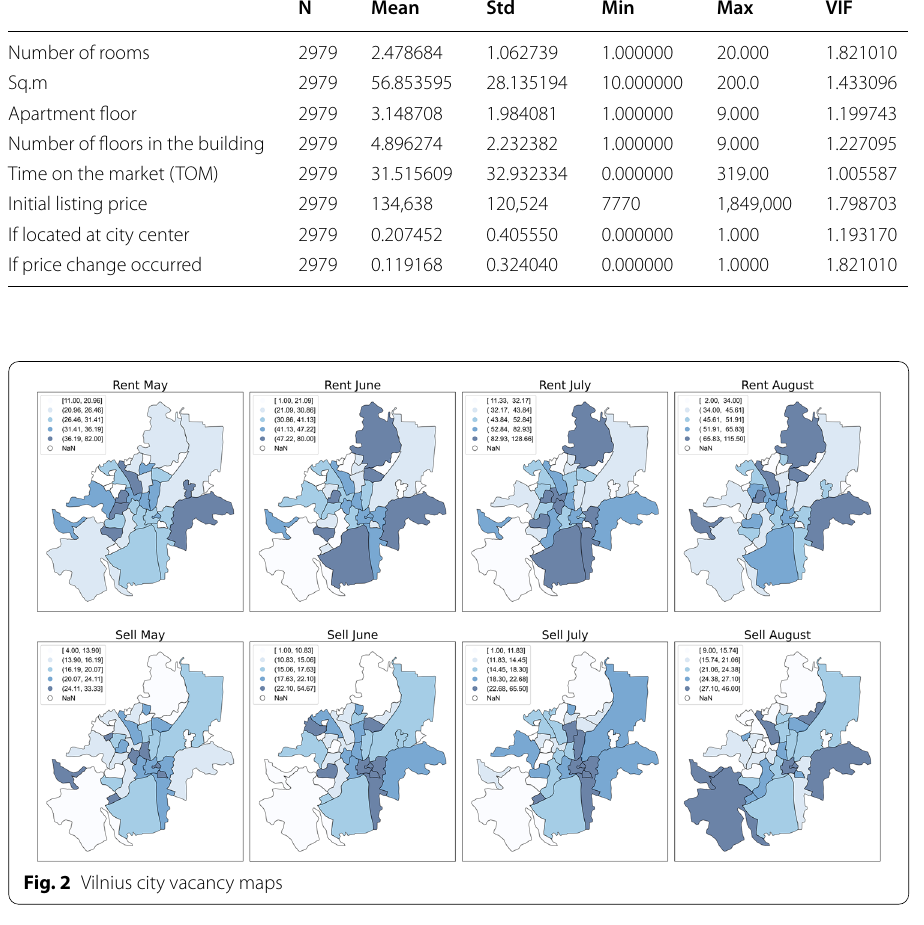
Fig. 2 Vilnius city vacancy maps